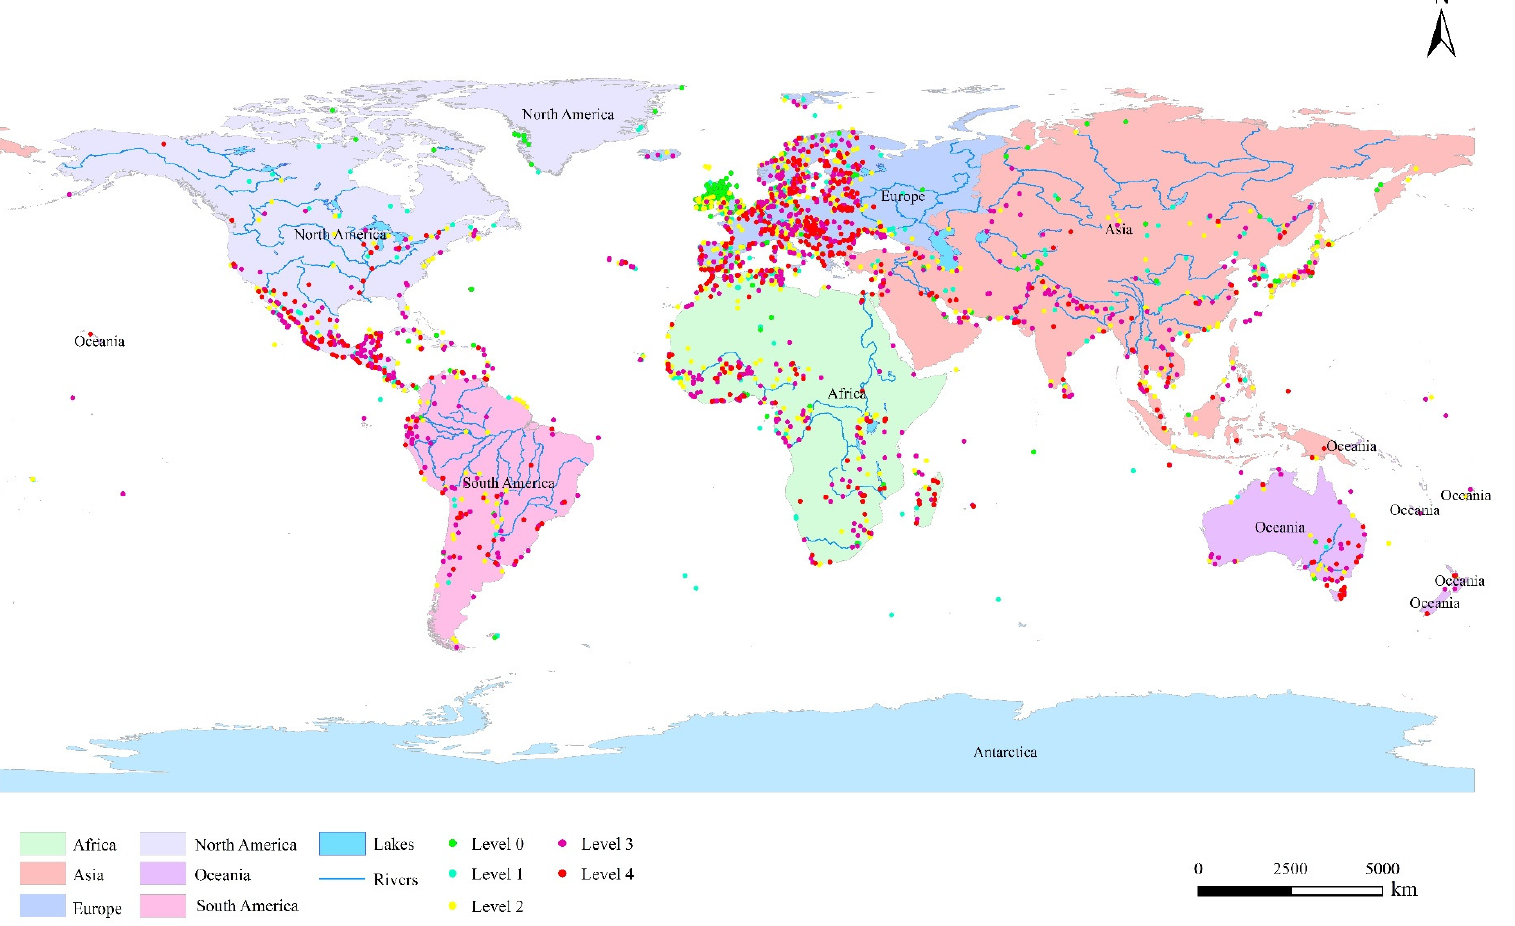
Figure 5. The distribution of the sites with different levels. By referring to the free data obtained from the Ramsar’s official website and conducting relevant calculations and statistics, the authors use the Arcgis 10.2 software to draw Figure 5. The data source is Reference [28].